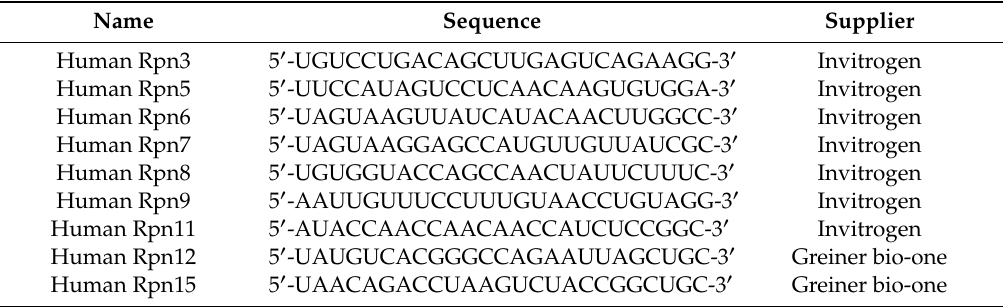
Table 1. RNAi sequences used in this study on the assembly pathway of the lid